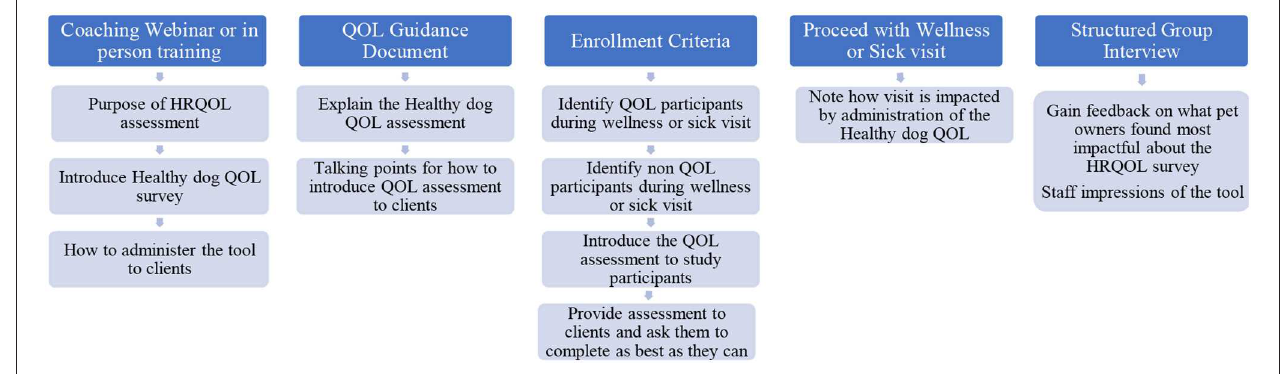
FIGURE 3 | Hospital staff training process diagram.